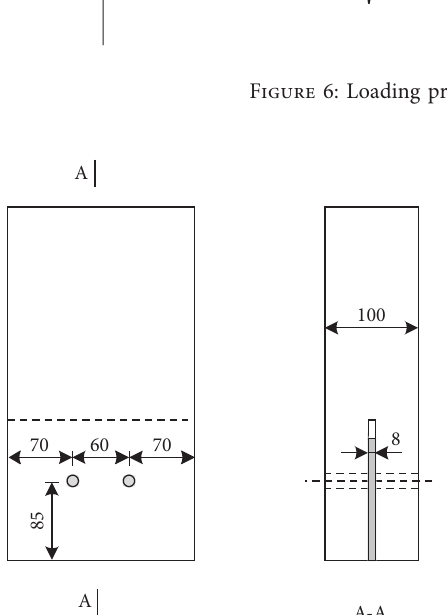
Figure 7: Detailed configurations of test bolted